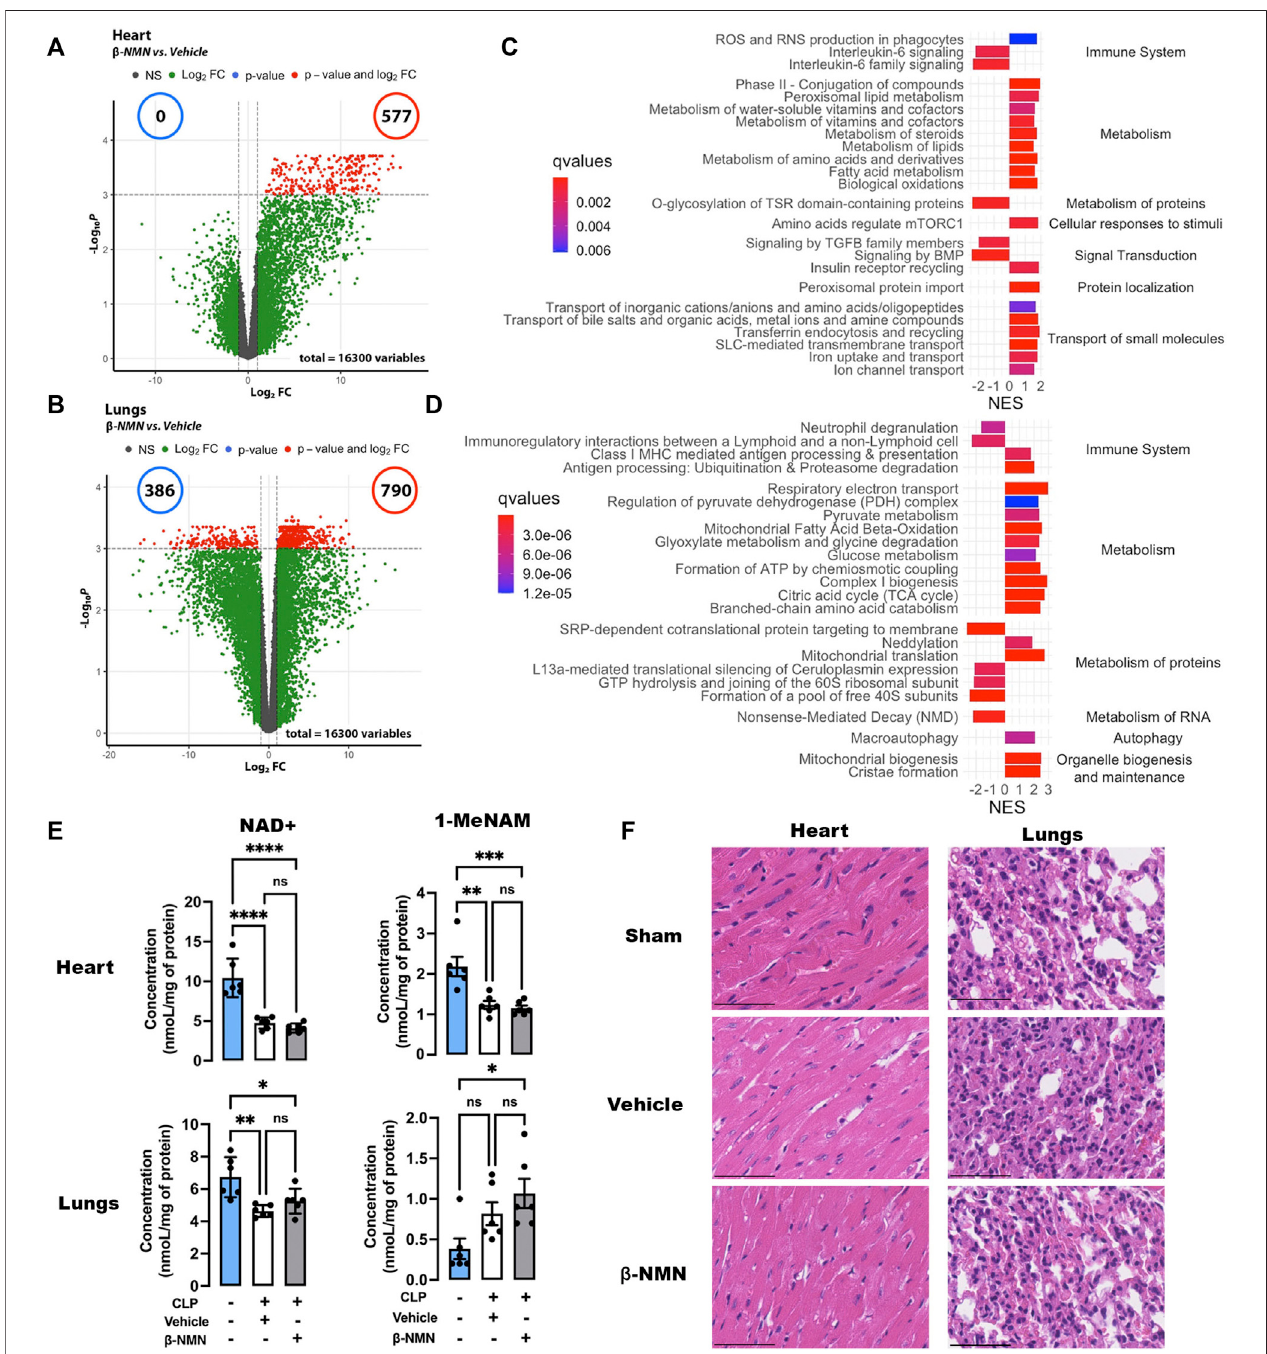
FIGURE 2 | Transcriptomic signatures, NAD+ and 1-MeNAM contents, and histology analysis of the heart and lungs of mice subjected to CLP. Hearts and lungs from vehicle and β -NMN mice were collected 24 h post CLP. (A,B) Volcano plots of the differentially expressed genes in the hearts (A) and lungs (B) . Volcano plots display log2-transformed fold-changes ( x -axis) vs. -log10 p -value ( y -axis). The red dots represent the gene having fold-changes > 2.0 and adjusted p -values < 0.05 between the two groups. n = 3 for each group. (C,D) Enrichment plot of differentially expressed Reactome pathways in the hearts (C) and lungs (D) . Normalized enrichmentscore (NES) re fl ects the up- (NES > 0) and down- (NES < 0)expressedpathways,and gradient colorre fl ectsthe adjusted p -values < 0.01; n =3for each group. (E) NAD+ and 1-MeNAM contents of hearts and lungs. Data are means ± SEM; n = 6 for each group; ns = non-signi fi cant; * p < 0.05; ** p < 0.01; *** p < 0.001; **** p < 0.0001. (F) RepresentativeH&Esection(x20) oftheheartsandlungsfromthesham, vehicle , and β -NMN mice.Therewasnohistopathological fi ndinginanyoftheheart and lung sections examined. n = 3 for each group.